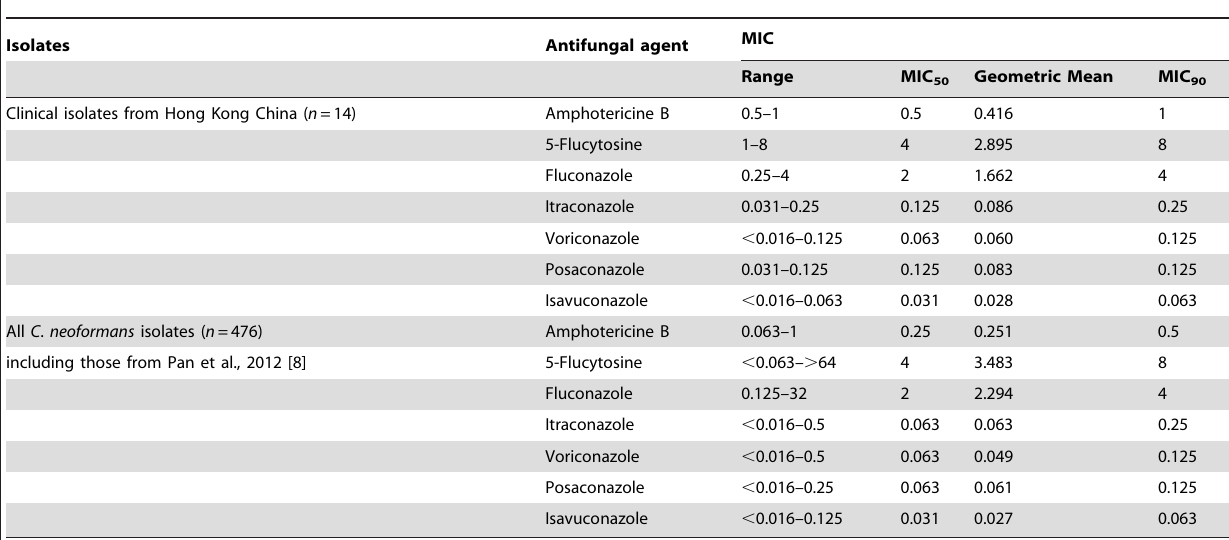
Table 8. The MIC range, MIC 50 , MIC 90 , and geometric mean for 14 Hong Kong and all 476 C . neoformans isolates for seven